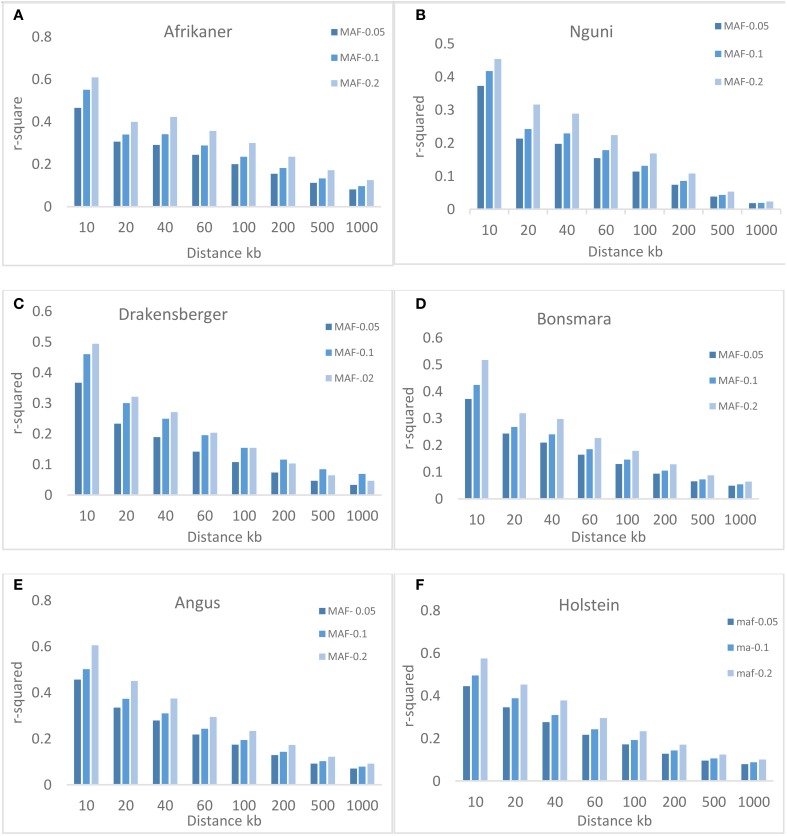
Average r2 estimates at different genetic distances for three different minor allele frequency (MAF) thresholds. Average LD estimates are pooled over all autosomal chromosomes: (A) Afrikaner, (B) Nguni, (C) Drakensberger, (D) Bonsmara, (E) Angus and, (F) Holstein.